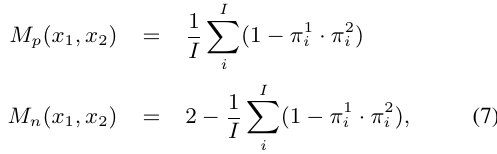
image pairs according to eq.